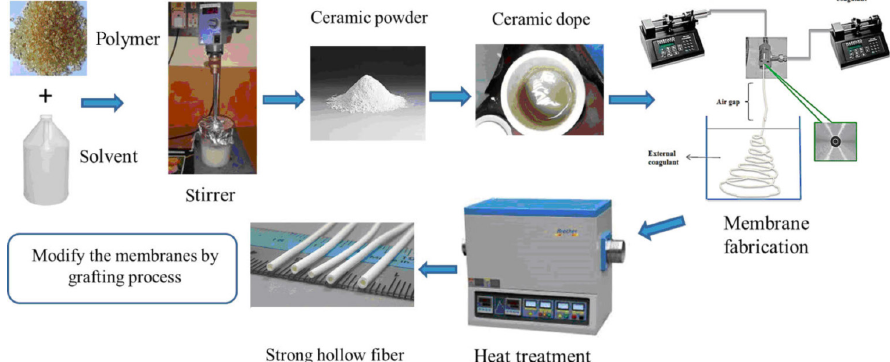
Fig. 1 Preparation of affordable kaolin–alumina hollow fibres using phase inversion and sintering